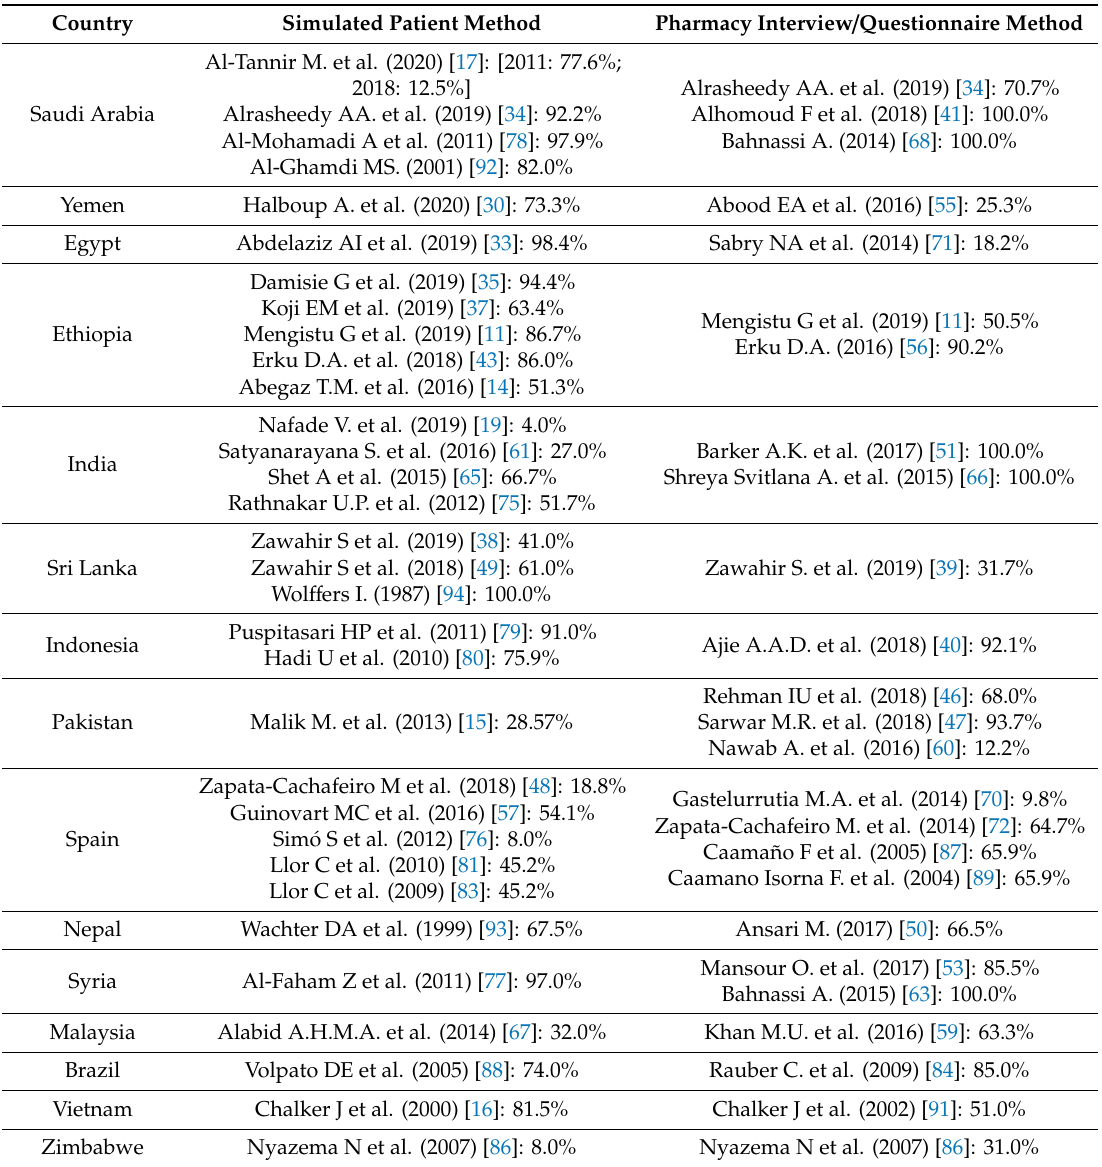
Table 5. Comparison of the frequency of antibiotic dispensation without a prescription between the two